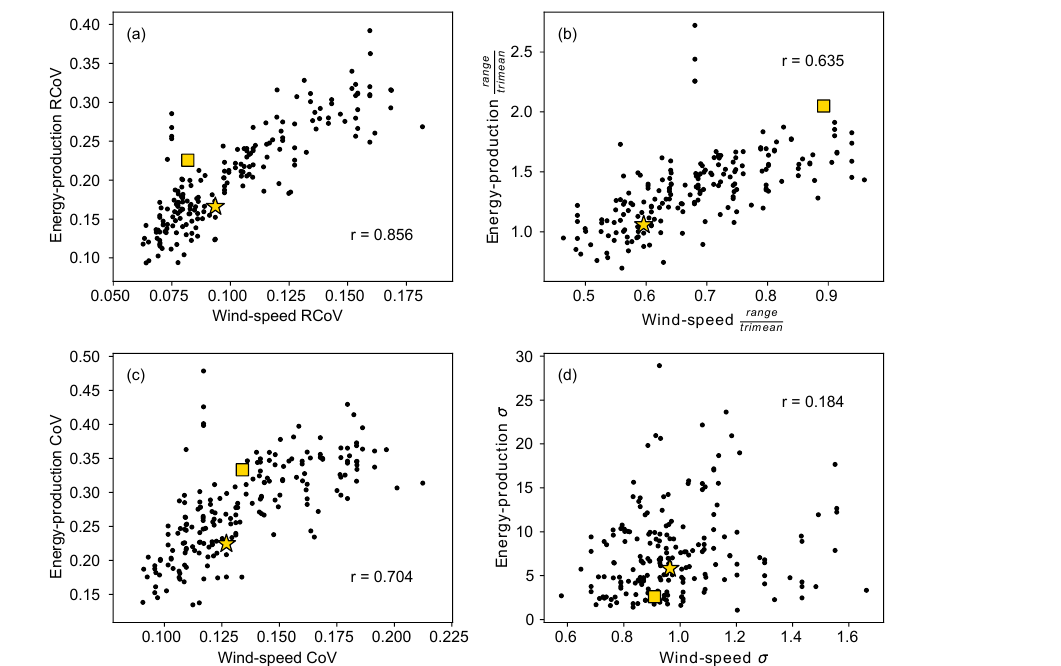
, (c) CoV, and (d) σ , trimean